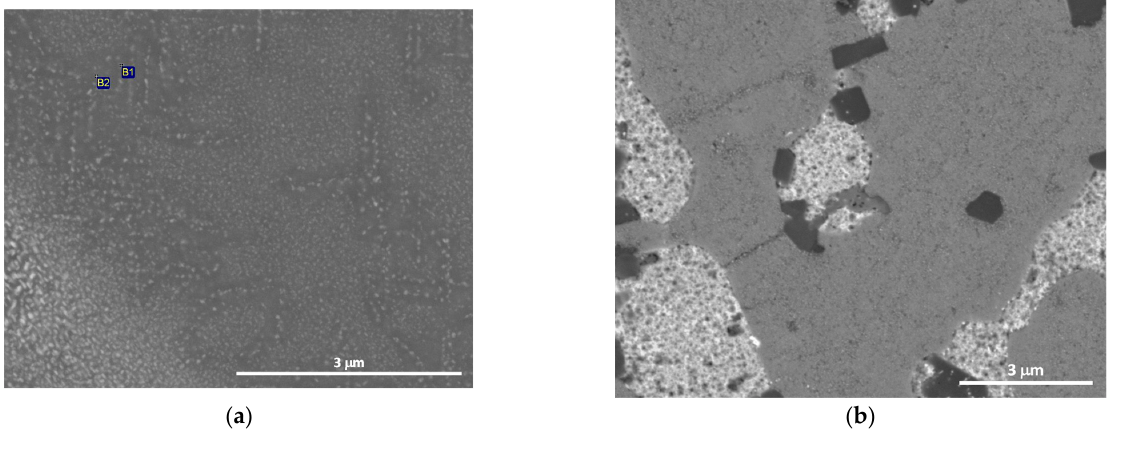
Figure 6. SEM micrographs of the Al–Zn matrix. ( a ) As-cast. ( b ) Q380. The identification of the phases present in each initial thermal condition was performed by room temperature X-ray diffraction (before the heating cycle). As is shown in Figure 7, in addition to the Al phase (PDF: 00-004-0787) and the Pt phase from the sample holder (PDF: 04-013-4766), which are not indicated for clarity, the phases detected were Zn (PDF: 01-078-9363), Si (PDF: 00-027-1402), MgZn 2 (PDF: 04-003-2083), Mg 2 Zn 11 (PDF: 04-007-1412), and Mg 2 Si (PDF: 01-083-5235).